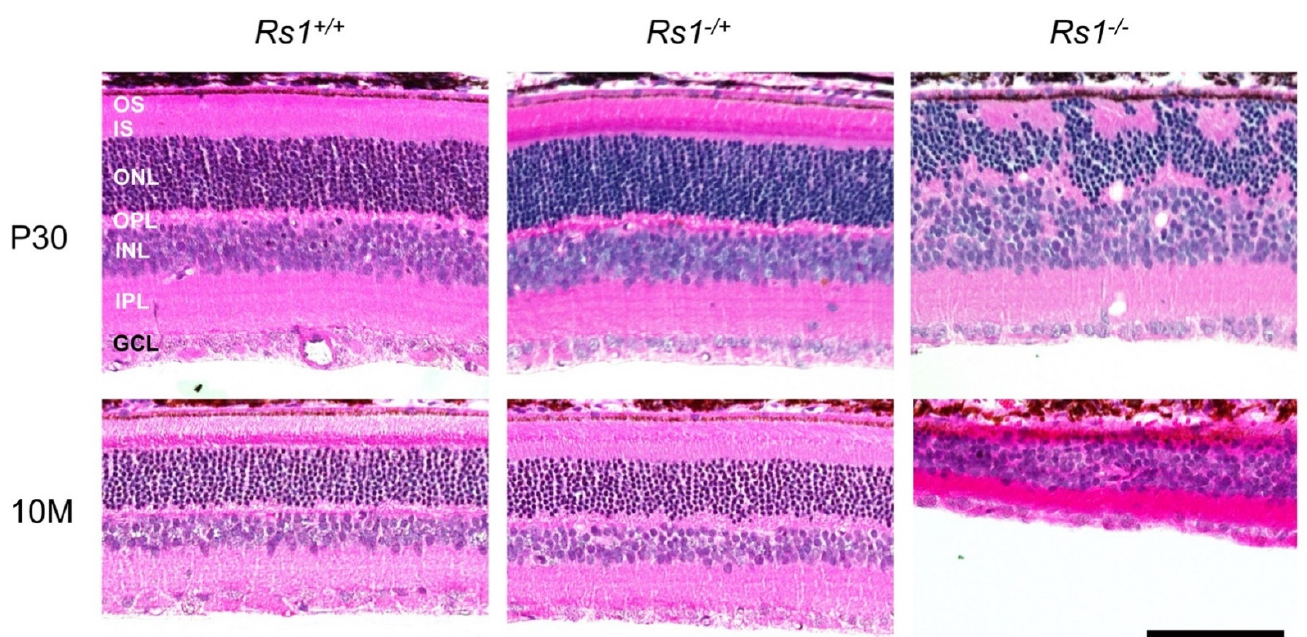
Figure 7. Histology of retinal structural changes of Rs1h -/- rat in females. Histology of female Rs1 +/+ , Rs1 -/+ and Rs1 -/- retinas at P30 and 10 months. No structural differences were observed between Rs1 +/+ and Rs1 -/+ female retinas at the examined time points. Furthermore, at examined time points, no differences were observed at this magnification between male (Figure 2A) and female KOs. The Rs1 -/- showed photoreceptor nuclei dislocated into the photoreceptor inner- and outer- segment (IS/OS) zone, with approx. 40% of the outer nuclear layer (ONL) remaining and a disrupted OPL by P30. At 10 months, the thickness of the OS, IS, ONL, outer plexiform layer (OPL), inner nucelar layer (INL), and inner plexiform layer (IPL) have been reduced; the ONL with only approx. 10% of the ONL remaining. Scale bar = 100 µ